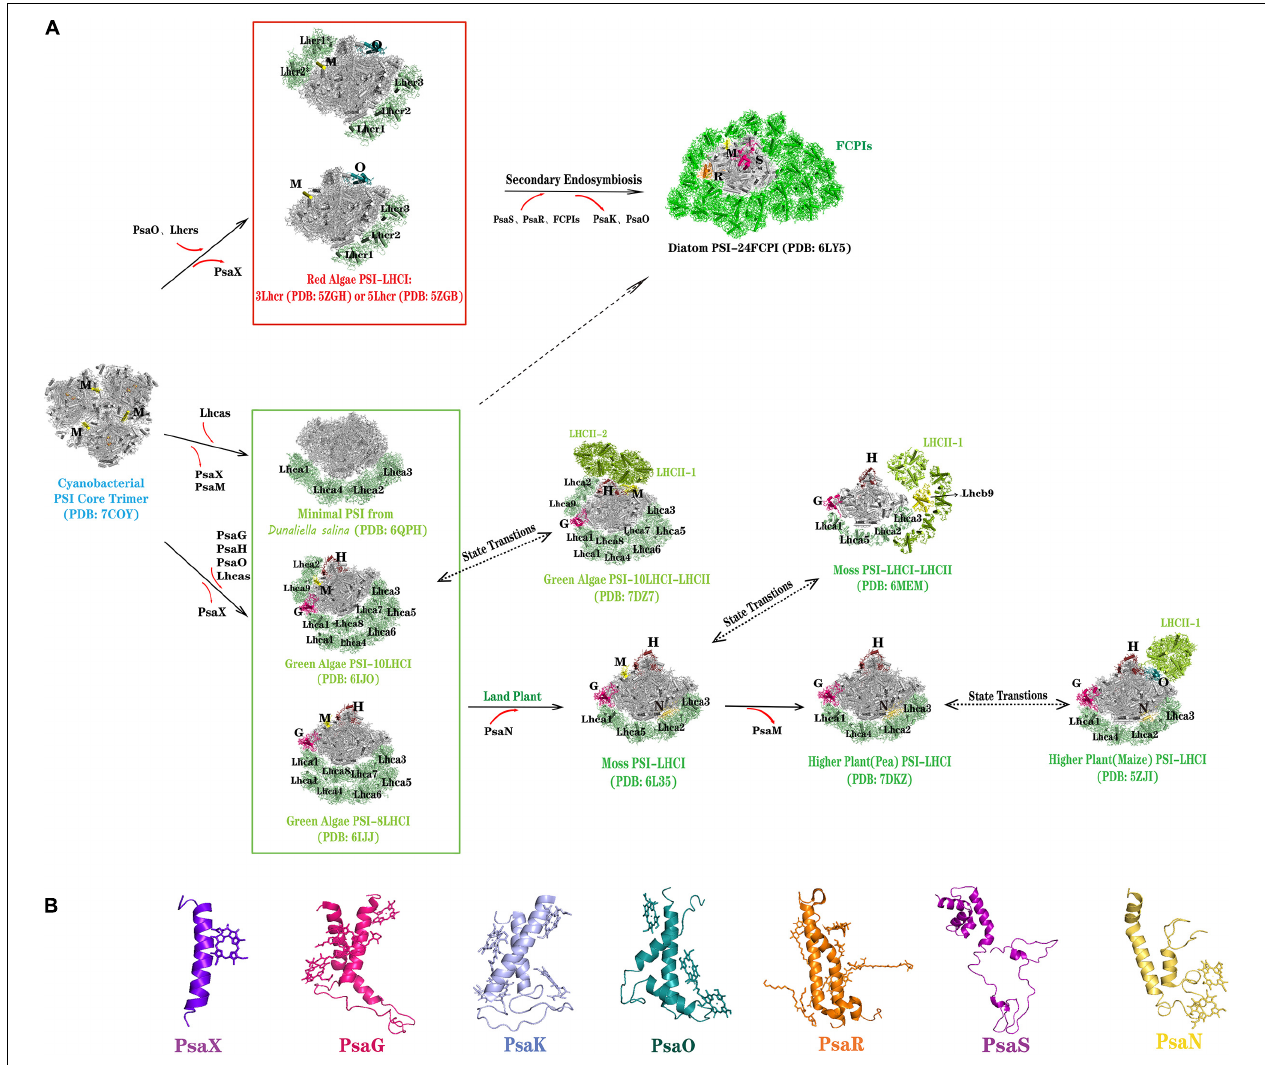
FIGURE 2 | Diversity of PSI-LHCI supercomplexes and PSI core subunits deriving from oxygenic photosynthesis organisms. (A) Different PSI-LHCI from oxygenic photosynthesis organisms. Light-harvesting antenna Lhcrs and the core subunit PsaO are appeared in red algae. In the second endosymbiosis event, the core subunits PsaS, PsaR and light-harvesting antenna FCPIs are appeared in diatoms, whereas PsaK and PsaO are not found in diatoms. The light-harvesting antenna Lhcas (8 or 10) and the core subunits PsaG, PsaH, and PsaO are appeared in green algae ( C. reinhardtii and B. corticulans ), except for the mini-PSI from Dunaliella salina which contains seven core subunits and four Lhcas. PsaX is lost in all photosynthetic eukaryotes. The peripheral light-harvesting antenna of PSI is simplified in bryophytes and vascular plants, and the core subunit PsaM of PSI is lost, but PsaN is appeared in plant PSI. LHCII binds to the PSI-LHCI supercomplex when the state transition occurs in green algae, bryophytes, and vascular plants. (B) Structure of the special PSI core subunits from different photosynthetic organisms: transmembrane core subunits—PsaX, PsaG, PsaK, PsaO, PsaR, and PsaN, and non-transmembrane core subunit —PsaS. Color codes used are as follows (PsaA, PsaB, PsaC, PsaD, PsaE, PsaF, PsaI, and PsaK are uniformly represented in gray because they are relatively conserved in the positions of different species): PsaX, purpleblue; PsaG, hot pink; PsaH, ruby; PsaK, light blue in panel (B) ; PsaM, yellow; PsaN, yellow-orange; PsaO, deep teal; PsaS, purple; PsaR, orange; FCPIs, green; LHCII, limon; lhcr/lhca,